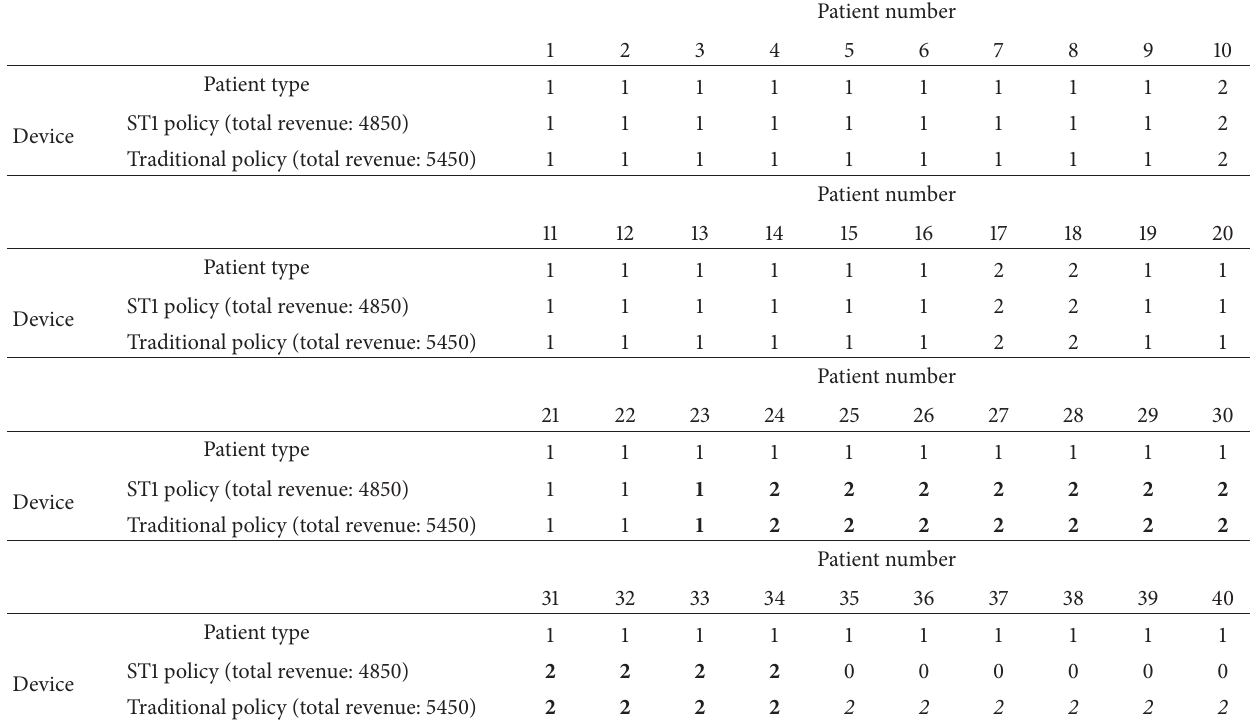
Table 1: Comparison of two strategies in Case